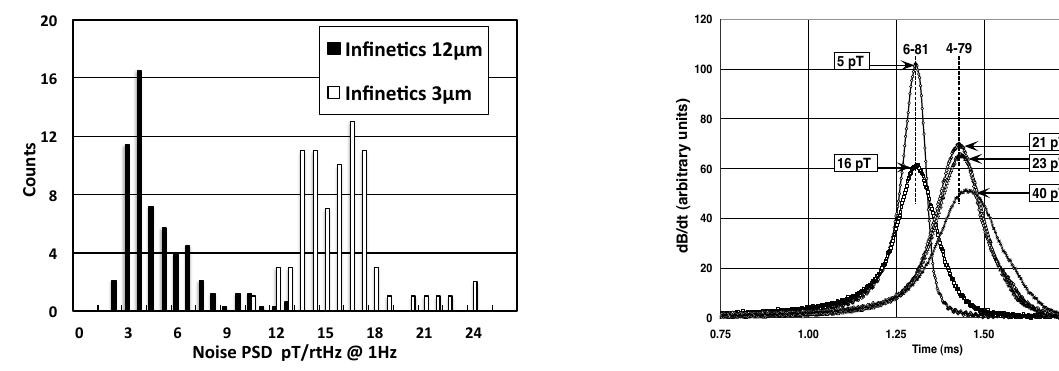
Figure 2. Histograms of noise power for 6–81 permalloy ring cores. Figure 3. d B/ d t plots for 6–81 and 4–79 ring cores. Noise values are in pTrtHz − 1 at 1Hz, for this insert and all other data in this